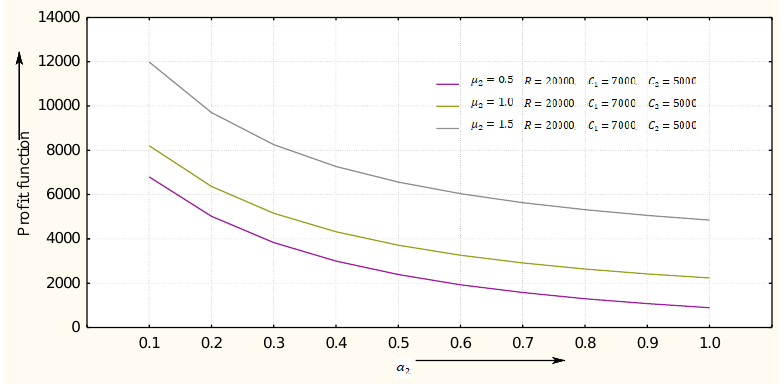
Figure 11. Behaviour of profit function w.r.t 𝛼